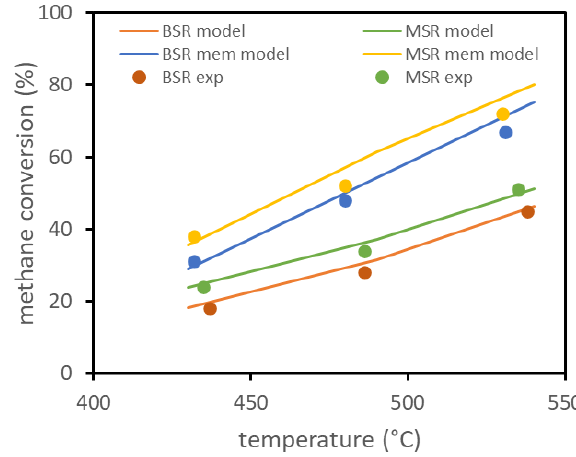
Figure 1. FBMR model validation based on lab-scale experimental data reported in literature.